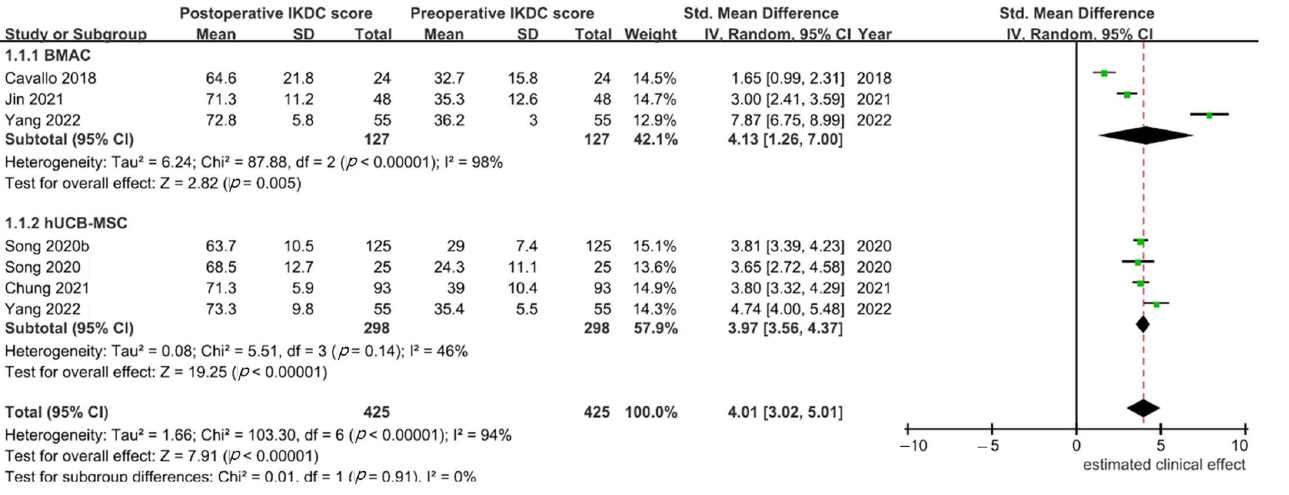
Figure 2. Estimated clinical effects of bone marrow aspirate concentrate (BMAC) and human umbilical cord blood-derived mesenchymal stem cells (hUCB-MSCs) in knee osteoarthritis (OA) patients treated with high tibial osteotomy (HTO) based on the International Knee Documentation Committee (IKDC) score